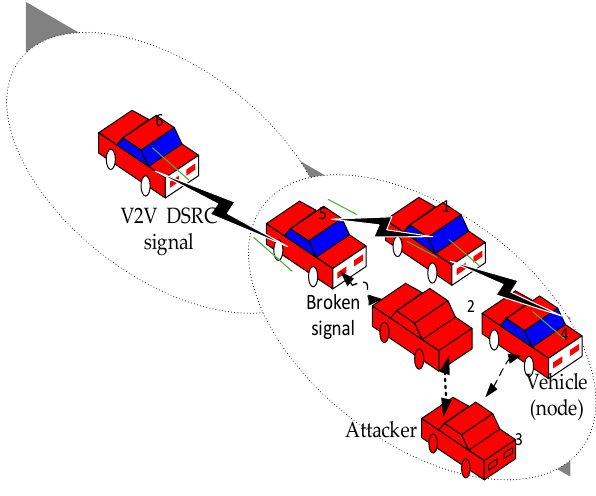
Figure 1. Channel Figure 1 . Channel occupancy.